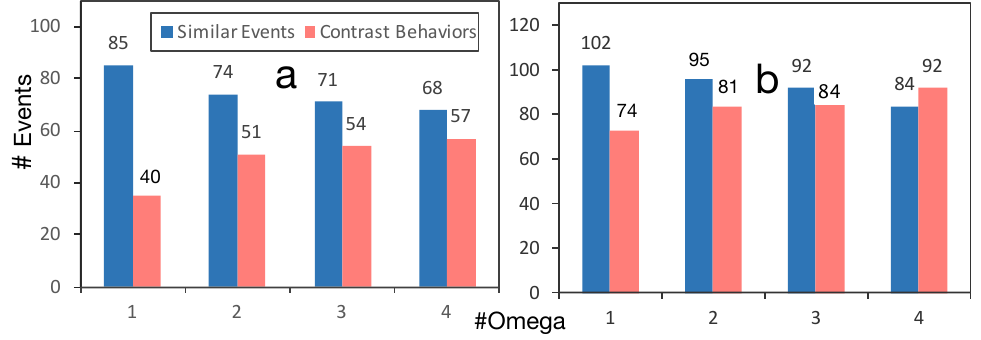
Figure 8. Parameter sensitivity of ω in ( a ) UbiqLog dataset and ( b ) Device Analyzer